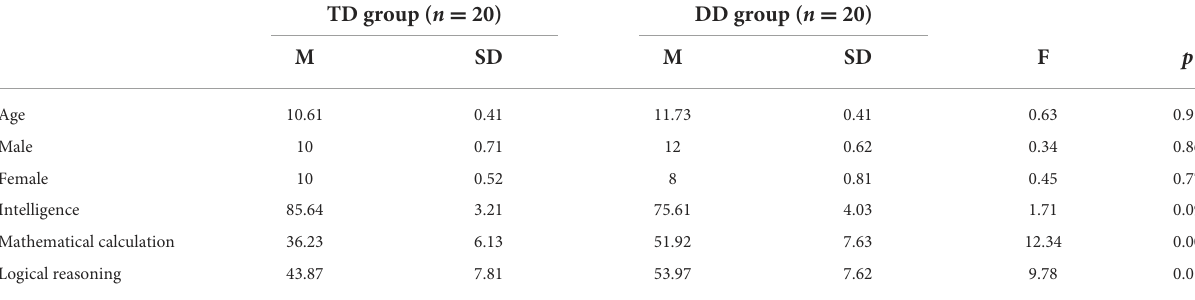
TABLE 1 Participants’